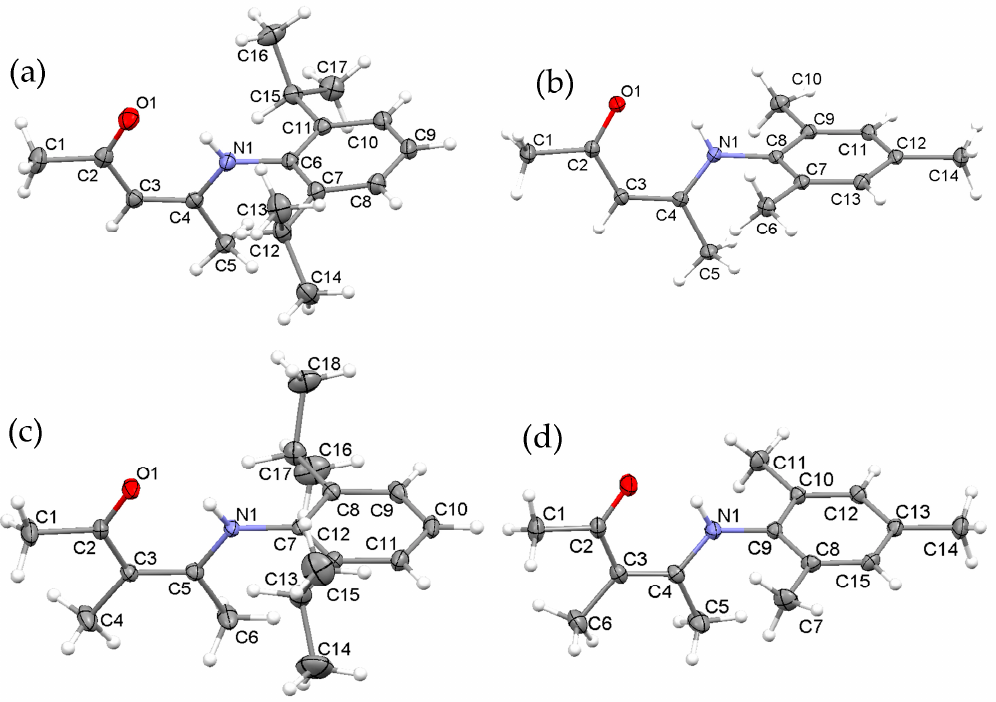
Figure 1. Displacement ellipsoids plots (40% probability) of the molecular structures of the ketoimine ligand precursors as found in the respective crystal structures: ( a ) Ligand 1a ; ( b ) ligand 1b ; ( c ) ligand 1c ; and ( d ) ligand 1d . The atom numbering schemes are indicated.